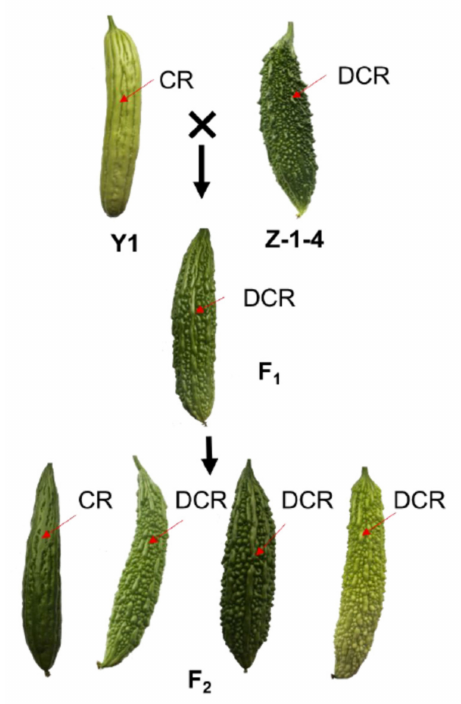
Figure 1. Segregation of ridge patterns on fruit skin in the Y1 × Z-1-4 population showing the recessive inheritance of continuous ridge pattern. CR: continuous ridge; DCR: discontinued